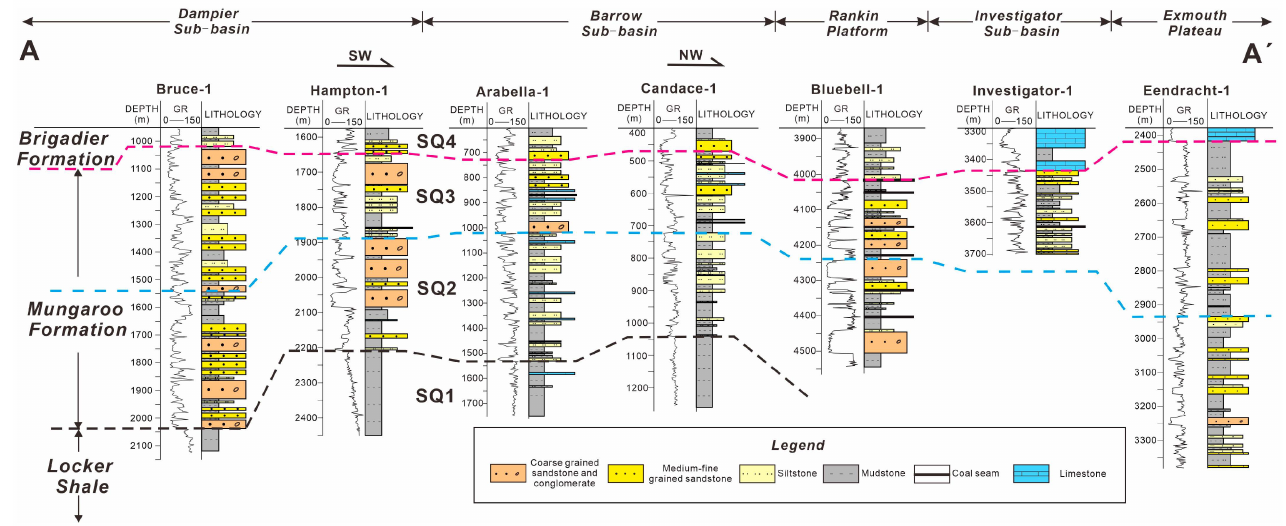
Figure 5. The cross-wells’ stratigraphic profile A–A (cid:48) of the Triassic Locker Shale (SQ1), Mungaroo Formation (SQ2 and SQ3), and Brigadier Formation (SQ4), showing the characteristics of the gamma ray (GR) wireline log, lithologies, lithological association, and vertical evolution from bottom to top. See Figure 1a for the location of the cross-wells profile A–A (cid:48)